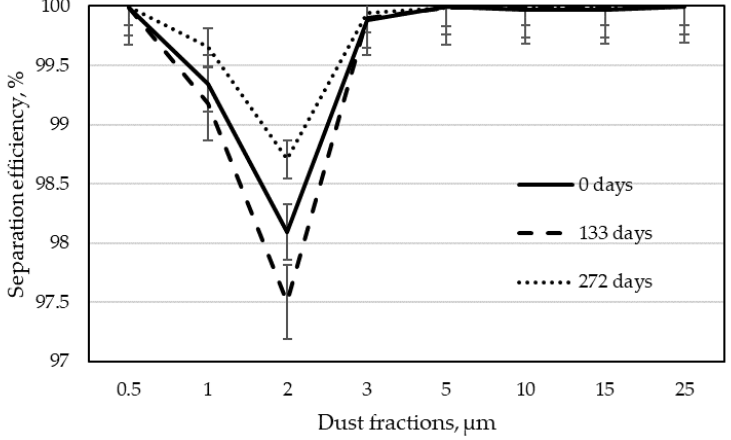
Figure 7. Fractional separation efficiency for filter bags from the dust extraction installations of drill- ing centers line in particular periods of use.